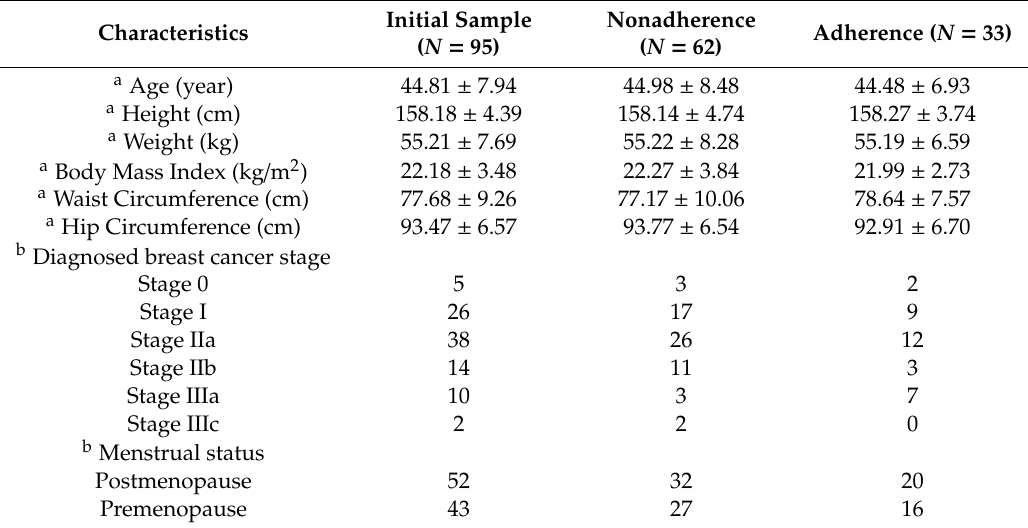
Table 3. Participant baseline